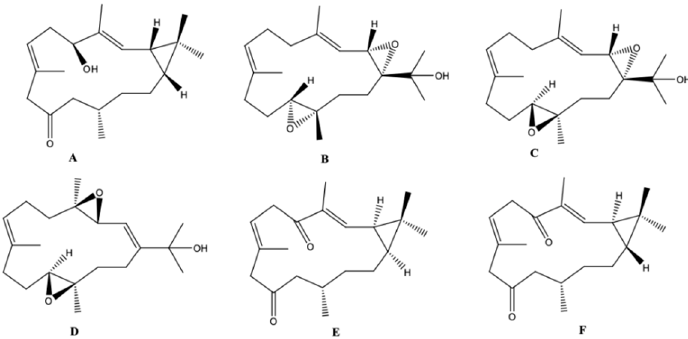
Figure 16. Casbanes and cembrane diterpenes from a soft coral Lobophytum collected in the coast of Irabu Island (Okinawa, Japan) [54].